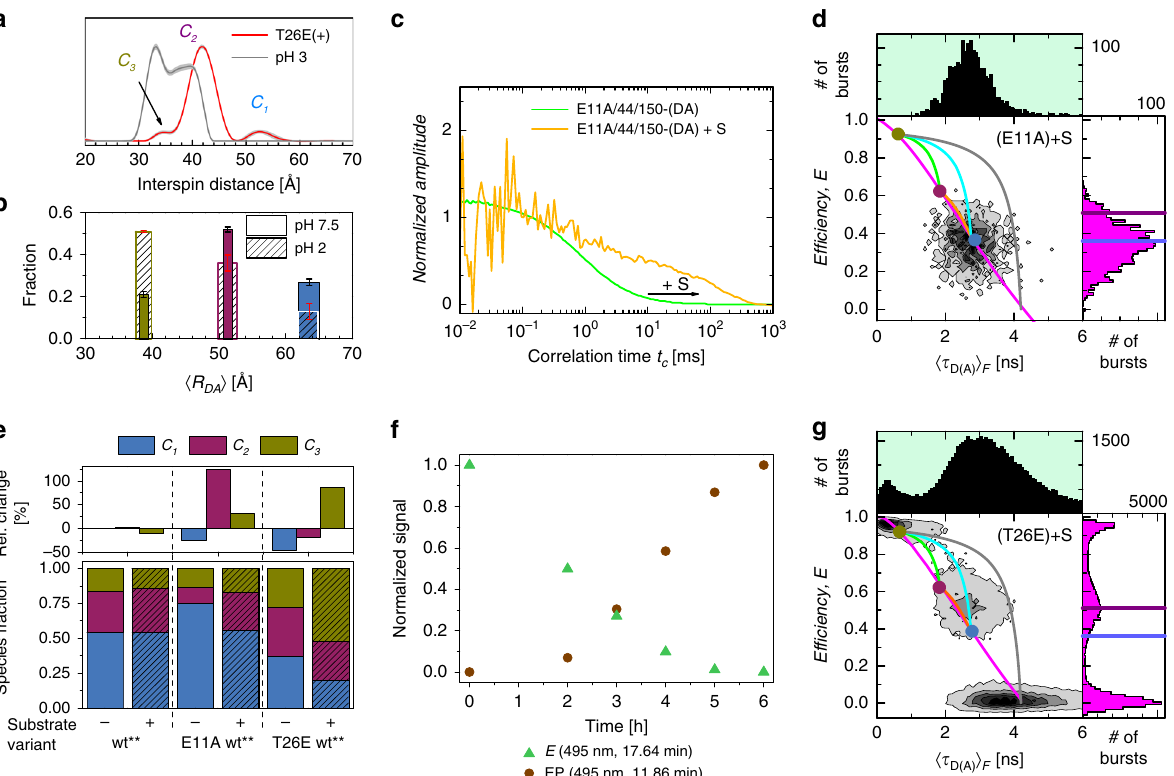
Fig. 6 Functional states of T4L. a Interspin distribution of T26E( + )-44R1/150R1 and 44R1/150R1 at pH 3.0 from DEER experiments. Gray area surrounding the distribution corresponds to error estimates. b Population fraction of S44pAcF/I150C from eTCSPC at pH 7.0 (solid colors) and at pH 2.0 (dashed rectangles). The width of the bar represents the uncertainty in distance ( fi lled bars: pH 7.5, hatched bars: pH 2). The error bars represent the statistical uncertainty in the amplitudes (black: pH 7.5, red: pH 2). C 3 increases in population at low pH. Similar effect is shown in EPR DEER experiments (Supplementary Fig. 5d) error estimates are 95% con fi dence intervals as determined by support plane analysis (Supplementary Methods). c , d The effects of the substrate on E11A/S44C/I150C: c Overlay of normalized sCCF of E11A/S44C/I150C with and without substrate. Consistent with the larger rotational correlation, we observe a shift of t diff towards longer times for the variant E11A/S44C/I150C when incubated with the substrate; d MFD-histograms for the variant E11A/S44C/I150C with substrate. Upon addition of the substrate, we observe a shift towards lower E values. e Species fractions of the variants S44pAcF/I150C (wt**), E11A/S44C/I150C (E11A wt**), and T26E/S44pAcF/I150C (T26E wt**) used to mimic free enzyme (E), enzyme-substrate complex (ES), and enzyme-product bound state (EP) without ( − ) and with ( + ) peptidoglycan. At the top, the relative change in fractions upon addition of peptidoglycan is shown. f , g Effects of the substrate on the variant T26E/S44pAcF/I150C: f Reverse-phase HPLC is used to monitor the adduct formation of the labeled T4L with peptidoglycan via plotting of the normalized signal at 17.64 min (E, green) and 11.86 min (EP, brown) after background subtraction; g MFD-histograms for the variant T26E/S44pAcF/I150C with substrate. An accumulation of the high FRET state is observed. The color code and FRET- lines for 2D and 1D MFD histograms ( d ) and g are as in Fig.